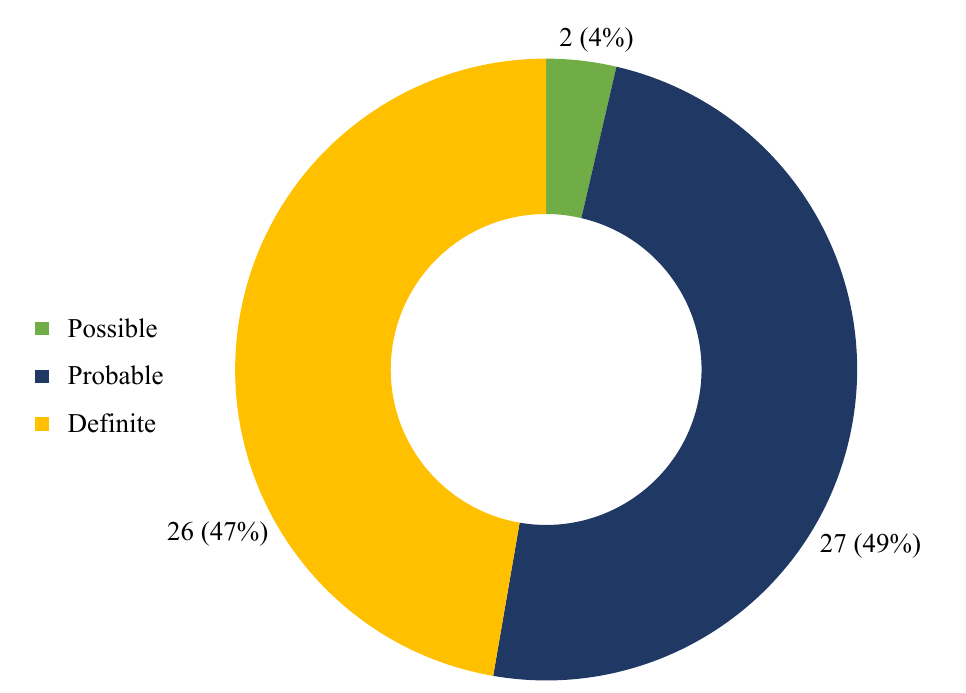
Figure 5. Age distribution of synthetic cannabinoid-induced acute kidney Figure 5. Causality assessment through Naranjo Adverse Drug Reaction Probability Scale.